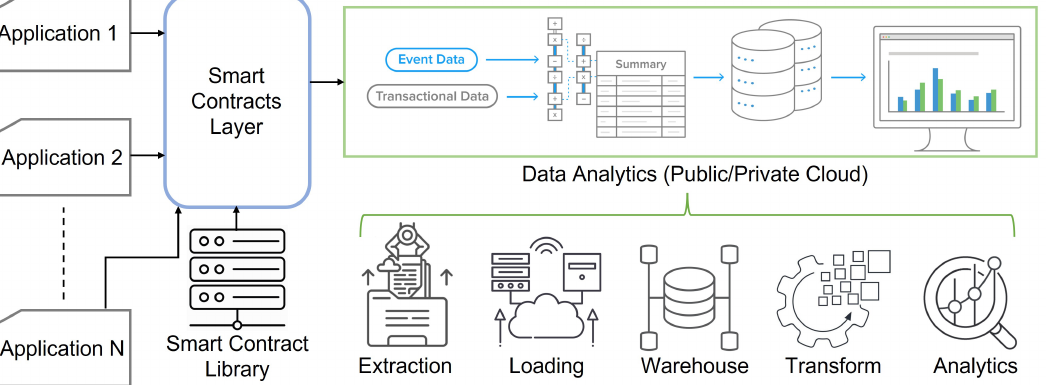
Figure 4. Flowchart of a smart contract-based Responsible AI setup with ETL for business intelligence and analytics (ETL: Extract, Transform, and